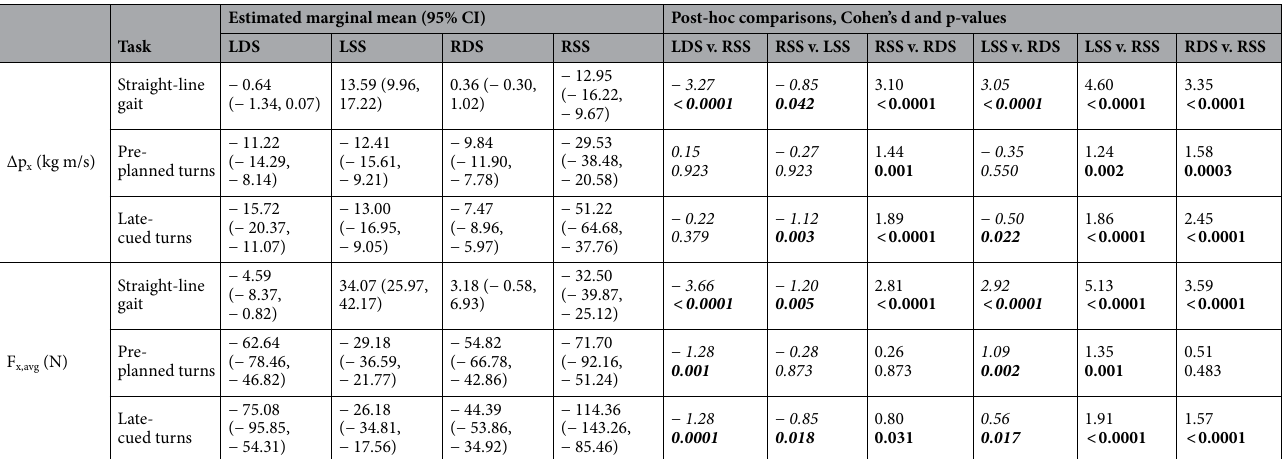
Table 2. Group-level estimated marginal means for study linear outcomes from linear mixed models. Acronyms: Left Double Support (LDS) Left Single Support (LSS), Right Double Support (RDS), Right